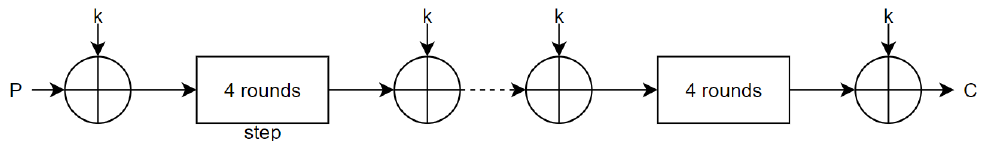
Figure 1. Representation of the LED encryption.